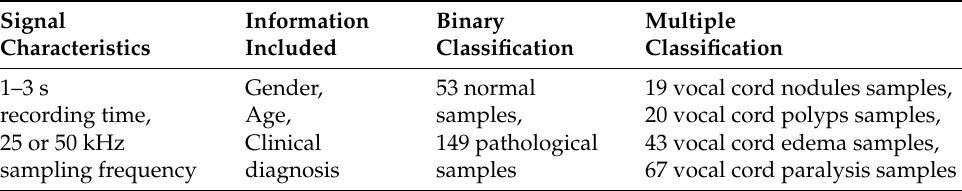
Table 1. The primary information in the Massachusetts Eye and Ear Infirmary (MEEI) database.